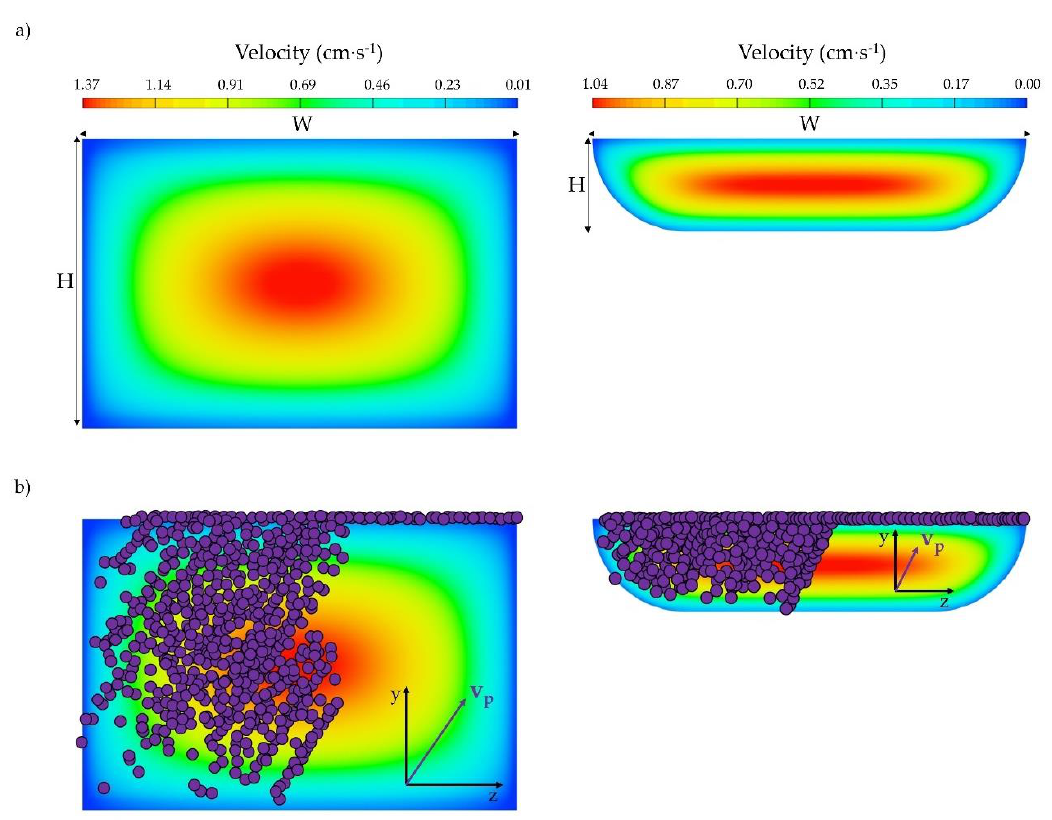
Figure 3. ( a ) Velocity distribution in a section perpendicular to the flow for rectangular (left) and U-shaped (right) cross section channels, and ( b ) particle location in these cross sections.